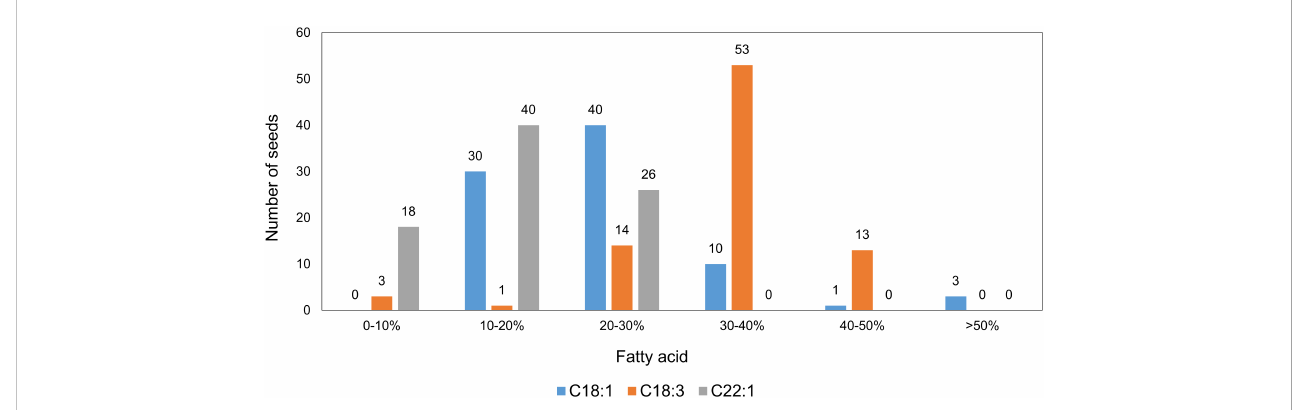
FIGURE 6 Distribution of major fatty acids in individual seeds from the T 1 generation of Mutant 4, analyzed by the half-seed method (total seed number = 84).